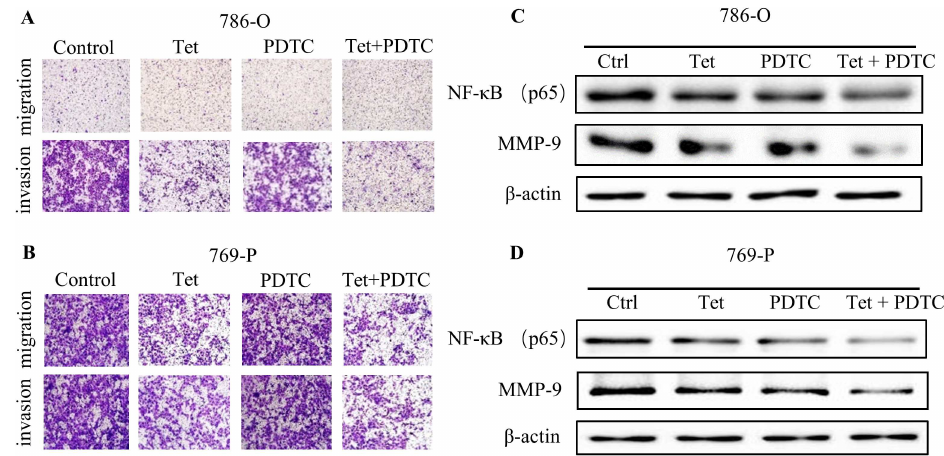
Fig 5. Tet represses cell migration and invasion of human RCC by negatively regulating NF- κ B expression. The metastatic phenotype of 786-O and 769-P was determinedby transwell assay. The migratedand invaded786-O ( A) and 769-P ( B ) cells were countedafter treatment with Tet (0.5 μ M), PDTC (10 μ M), or the both for 24 h. Under similar treatment, lysates from 786-O ( C ) and 769-P ( D ) cells treated with Tet or PDTC were immunoblotted for MMP-9 and NF- κ B. All the experiments were performed in triplicate. Representative results from three independentexperimentswere